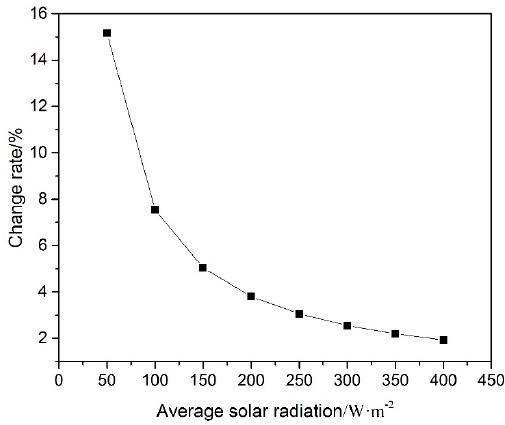
Figure 4. Percentage change of the heat storage power with different average solar radiation when the outdoor temperature varies by 10 °C.